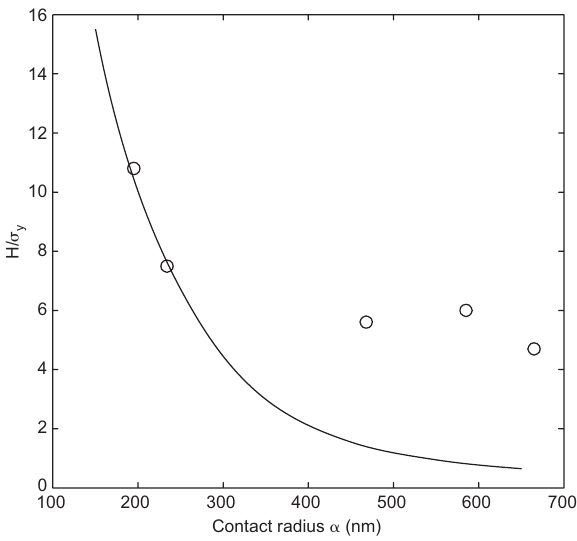
Figure 4 Variation of reduced hardness H / σ to the contact radius a . Experimental measurements in [10] are rep- resented with open circles, while theoretical predictions based on Eq. (23) are represented with a continuous line.